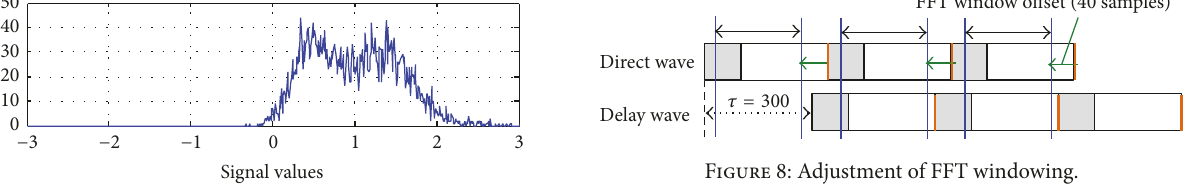
Figure 7: Received signal distribution affected by ICI.